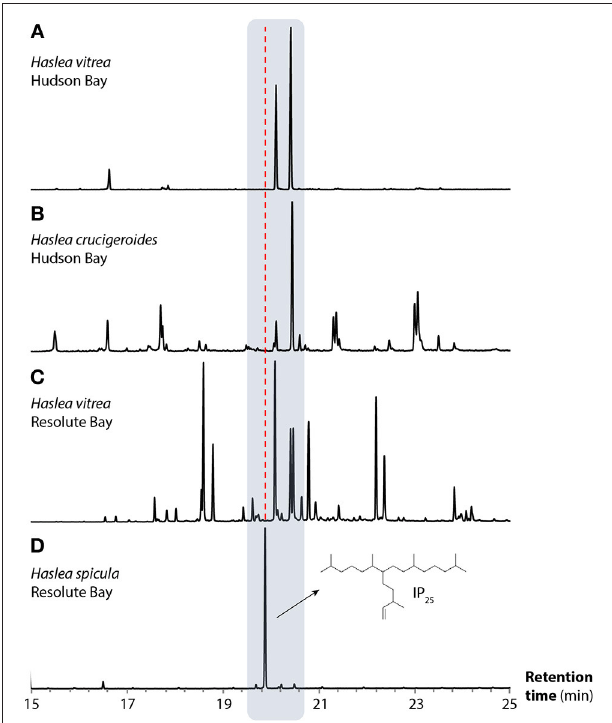
FIGURE 4 | Partial GC-MS TIC chromatograms of hydrocarbon extracts obtained from Haslea spp. cultures: (A) Haslea vitrea isolated from sea-ice collected from Churchill, Hudson Bay, (B) Haslea crucigeroides (Hudson Bay), (C) Haslea vitrea (Resolute Bay), and (D) Haslea spicula (Resolute Bay). The structure of IP 25 is also illustrated. The x axis corresponds to the retention time (min.). The gray box shows the chromatograms corresponding to HBIs, and the red dashed line shows that of IP 25 . Amongst the species shown here, only H. spicula produces IP 25